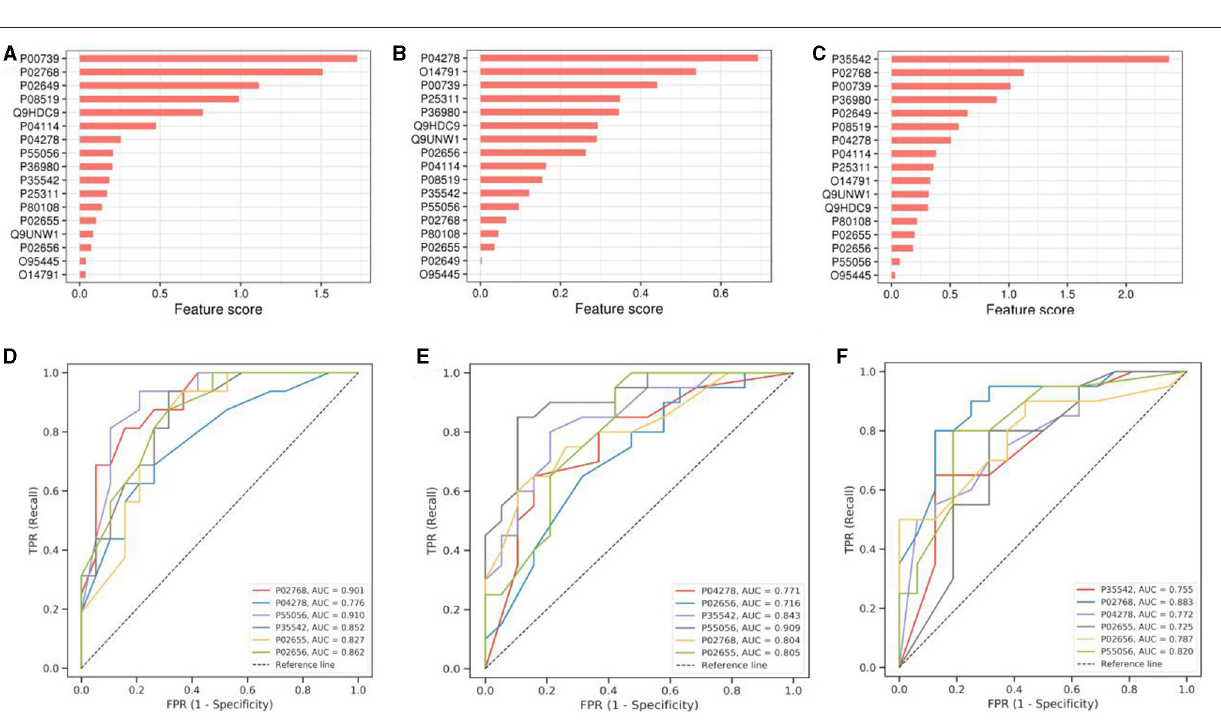
FIGURE 4 | Machine Learning-Results of Random Forest Experiment. (A–C) shows the histogram of protein characteristics. (D–F) is the ROC curve drawn according to the target protein. SCAD and healthy people are in groups (A,D) , SCAD and AMI are in groups (B,E) , while the healthy people and AMI are in groups (C,F) . The protein name and AUC are in the lower right corner of the corresponding picture. The ordinate is sensitivity and the abscissa is